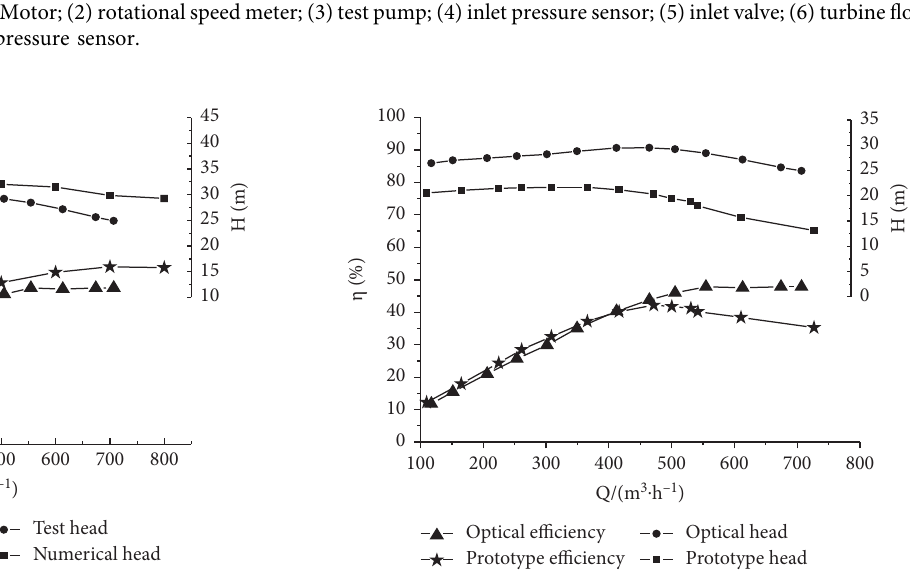
Figure 6: Comparison between the numerical and experimental results of the optimization model performance.